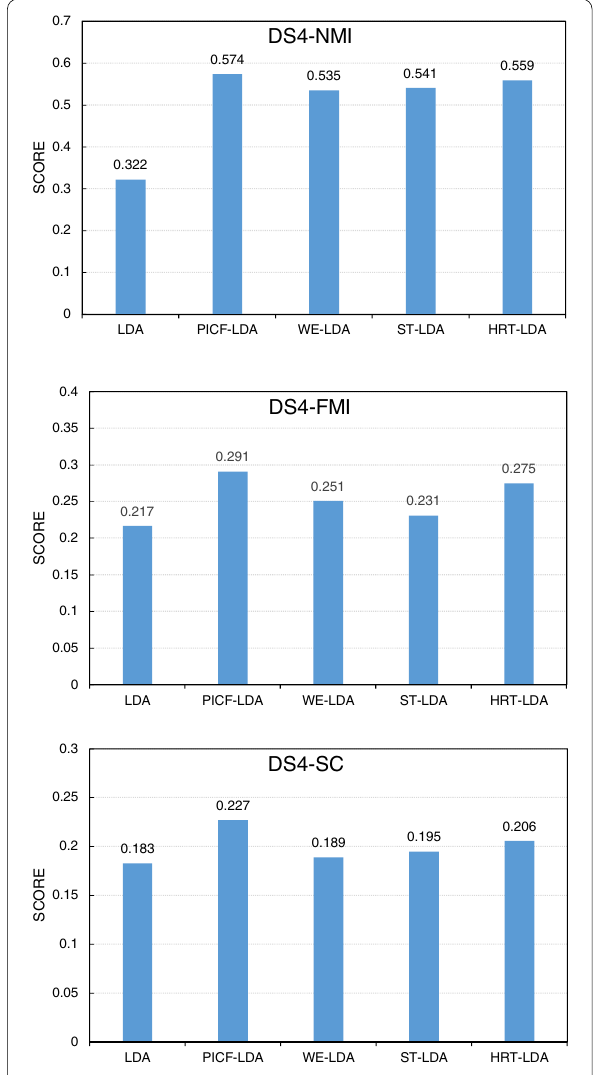
Fig. 8 Performance comparison between PICF-LDA and variant LDA models in DS4